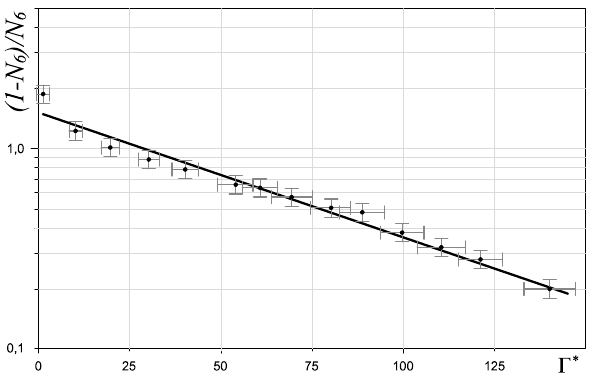
Figure 6. Log–norm plot of the ratio of the defect fractions to the nondefect fraction, (1 − N 6 )/ N 6 as a function of effective coupling parameter Γ *